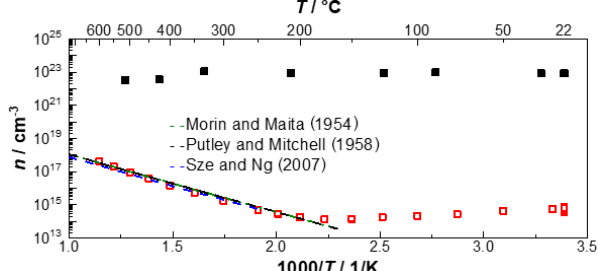
Figure 11. Arrhenius-like representation of the charge carrier den- sities of a gold thin film (thickness 200nm) and a boron-doped sil- icon wafer (thickness 380µm) calculated from the Hall coefficient up to 600 ◦ C, with an additional comparison of the charge carrier density adapted from Morin and Maita (1954), Putley and Mitchell (1958), and Sze and Ng